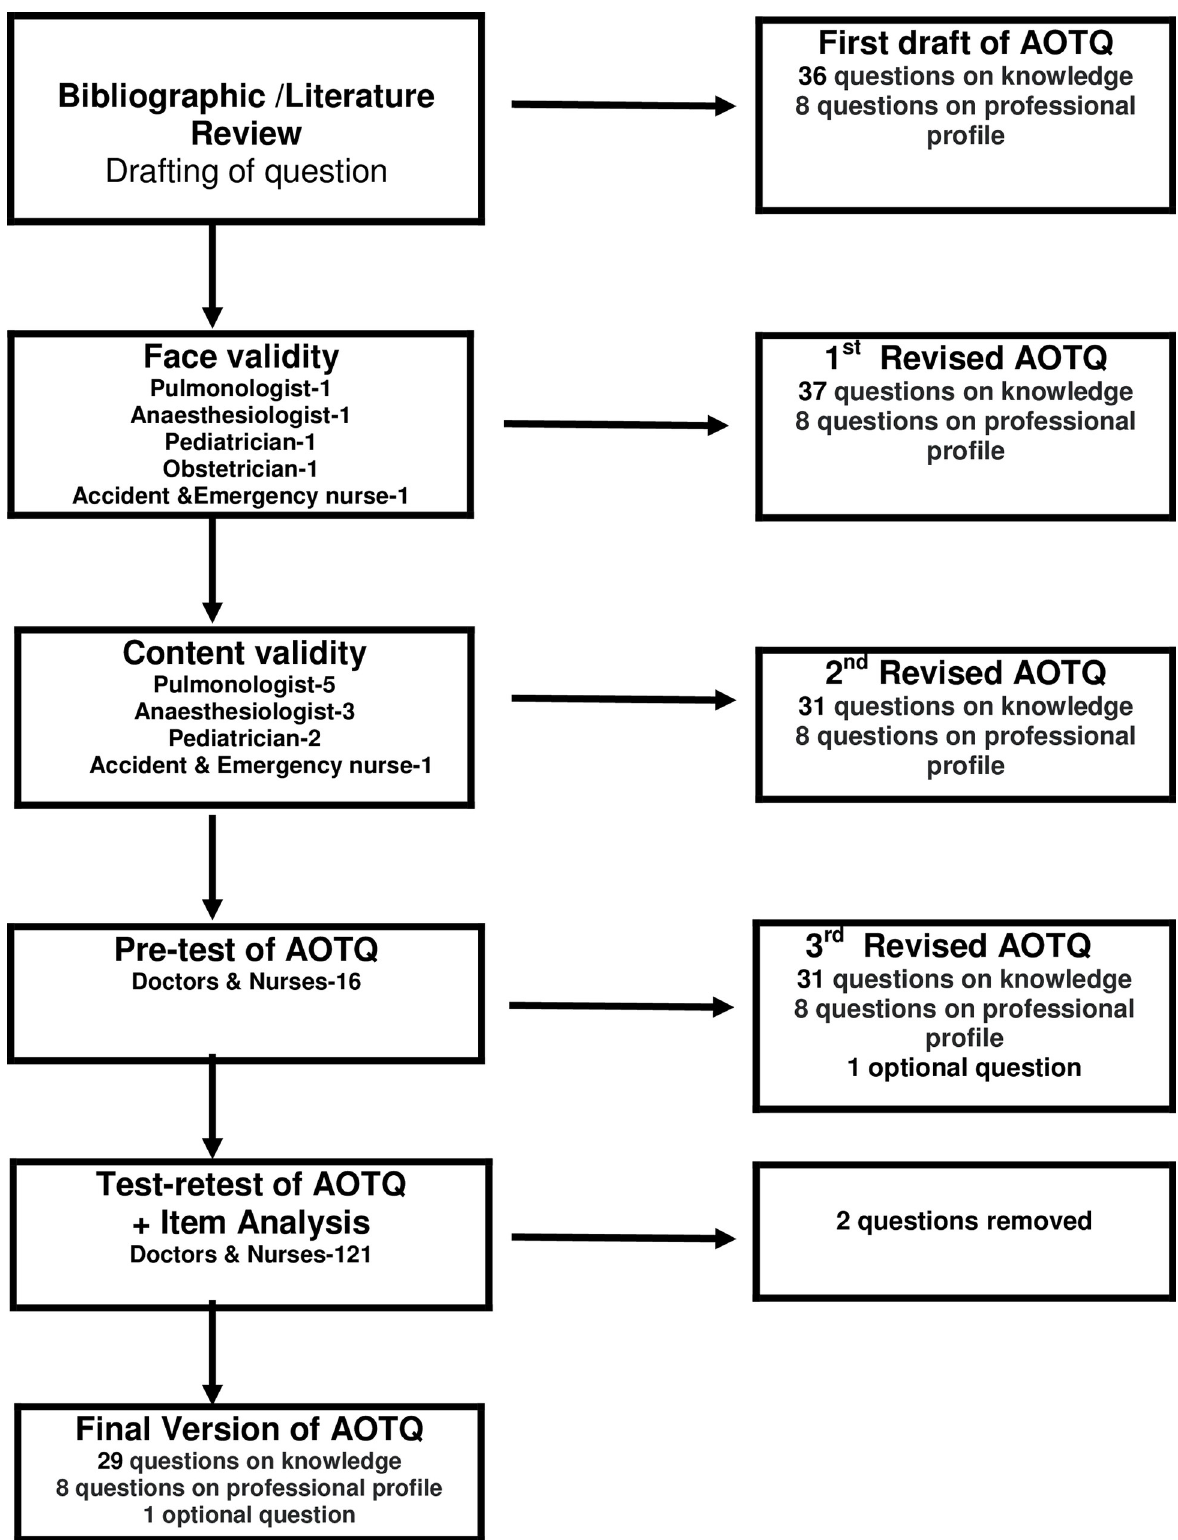
Fig 1. Flow chart of the development and validity of the questionnaire.